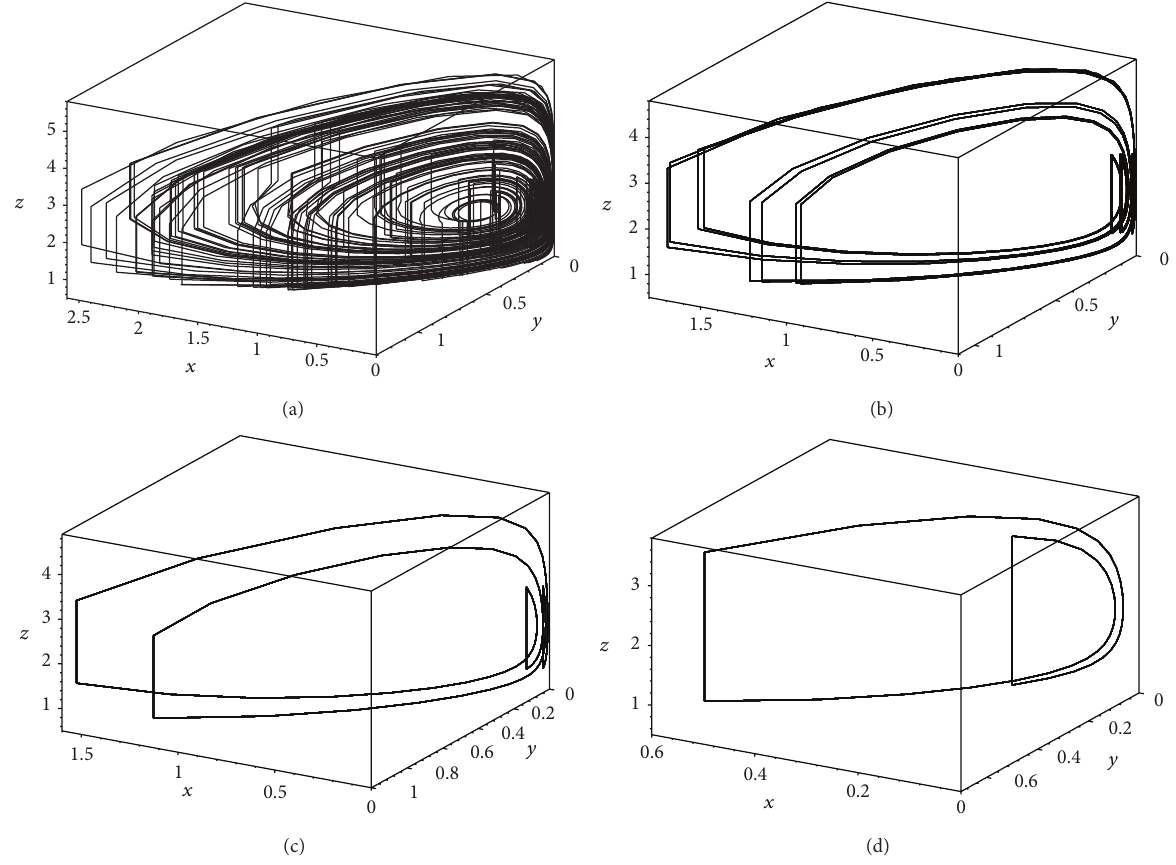
Figure 3: Transition from chaos to period-halving in System (2): (a) chaos when 𝑝 = 1.5 ; (b) 8T-periodic solution when 𝑝 = 1.73 ; (c) 4T-periodic solution when 𝑝 = 1.85 ; (d) 2T-periodic solution when 𝑝 = 2.5